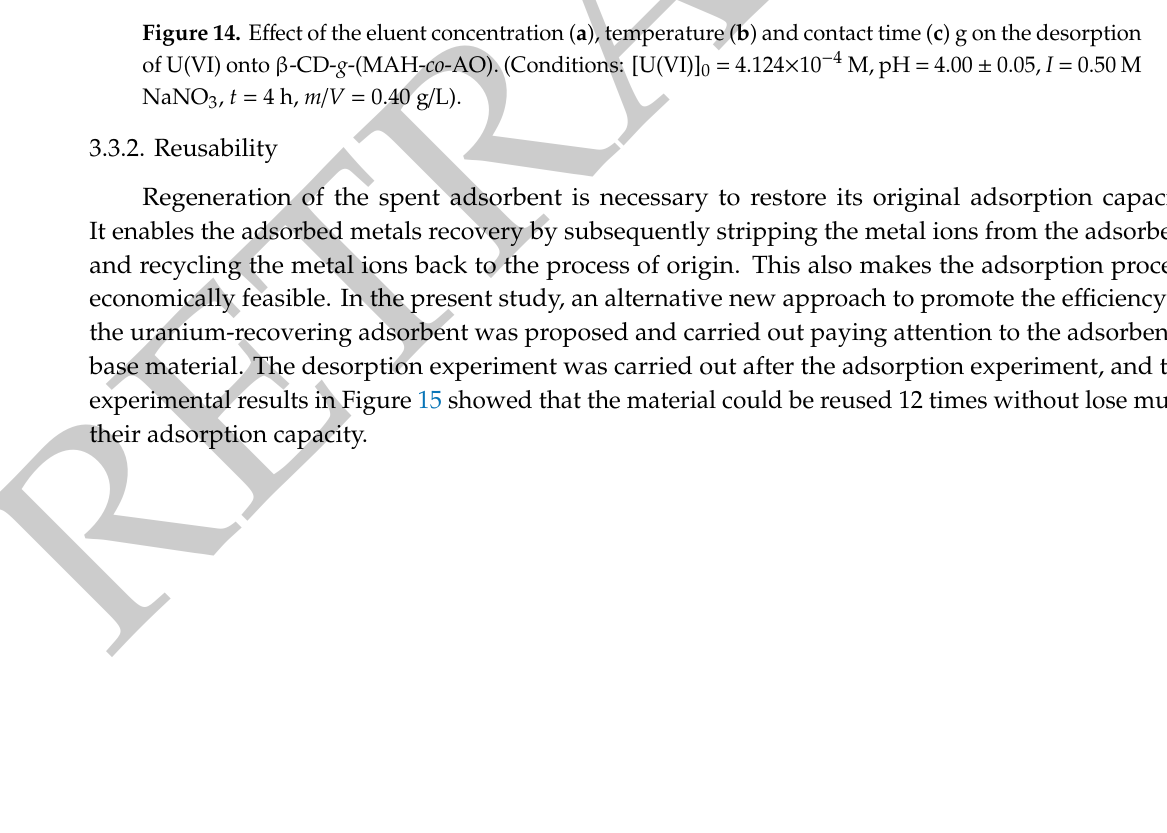
Figure 15. The amount of U(VI) adsorbed as a function of the adsorption-desorption cycle. (Conditions: [U(VI)] 0 = 4.1240×10 -4 M, m / V = 0.40 g/L, I = 0.50 M NaNO 3 , pH = 4.00 ± 0.05, t = 4 h; desorption eluent = 0.10 M HNO 3 .